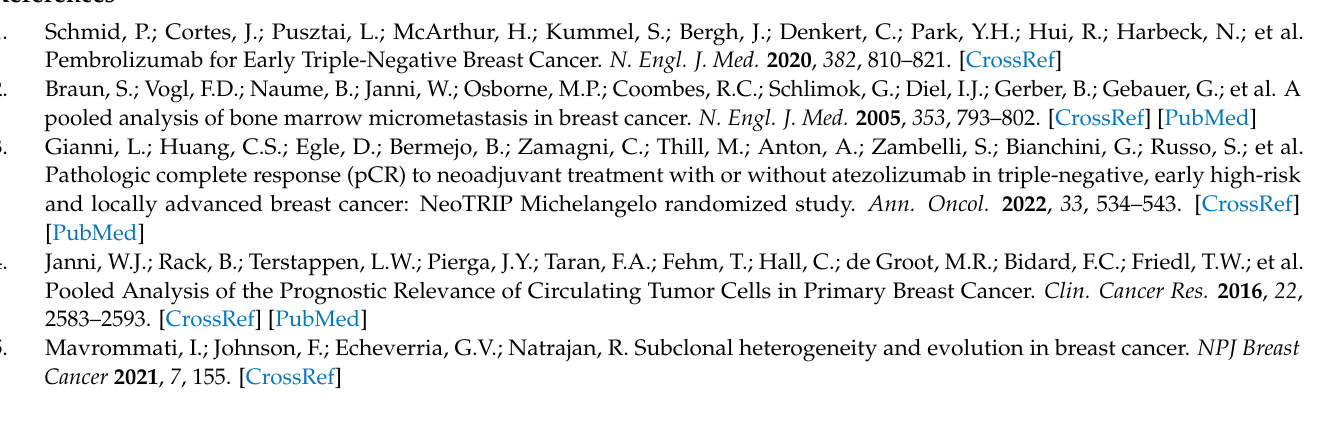
Figure S2: Uncropped Western blots used for Figure 5. Figure S3: An additional PD-L1 Western blot similar to the one shown in Figure 5. Figure S4: Effect of low-dose JQ1 on the morphology of FC-IBC02 and FC-IBC02-MA